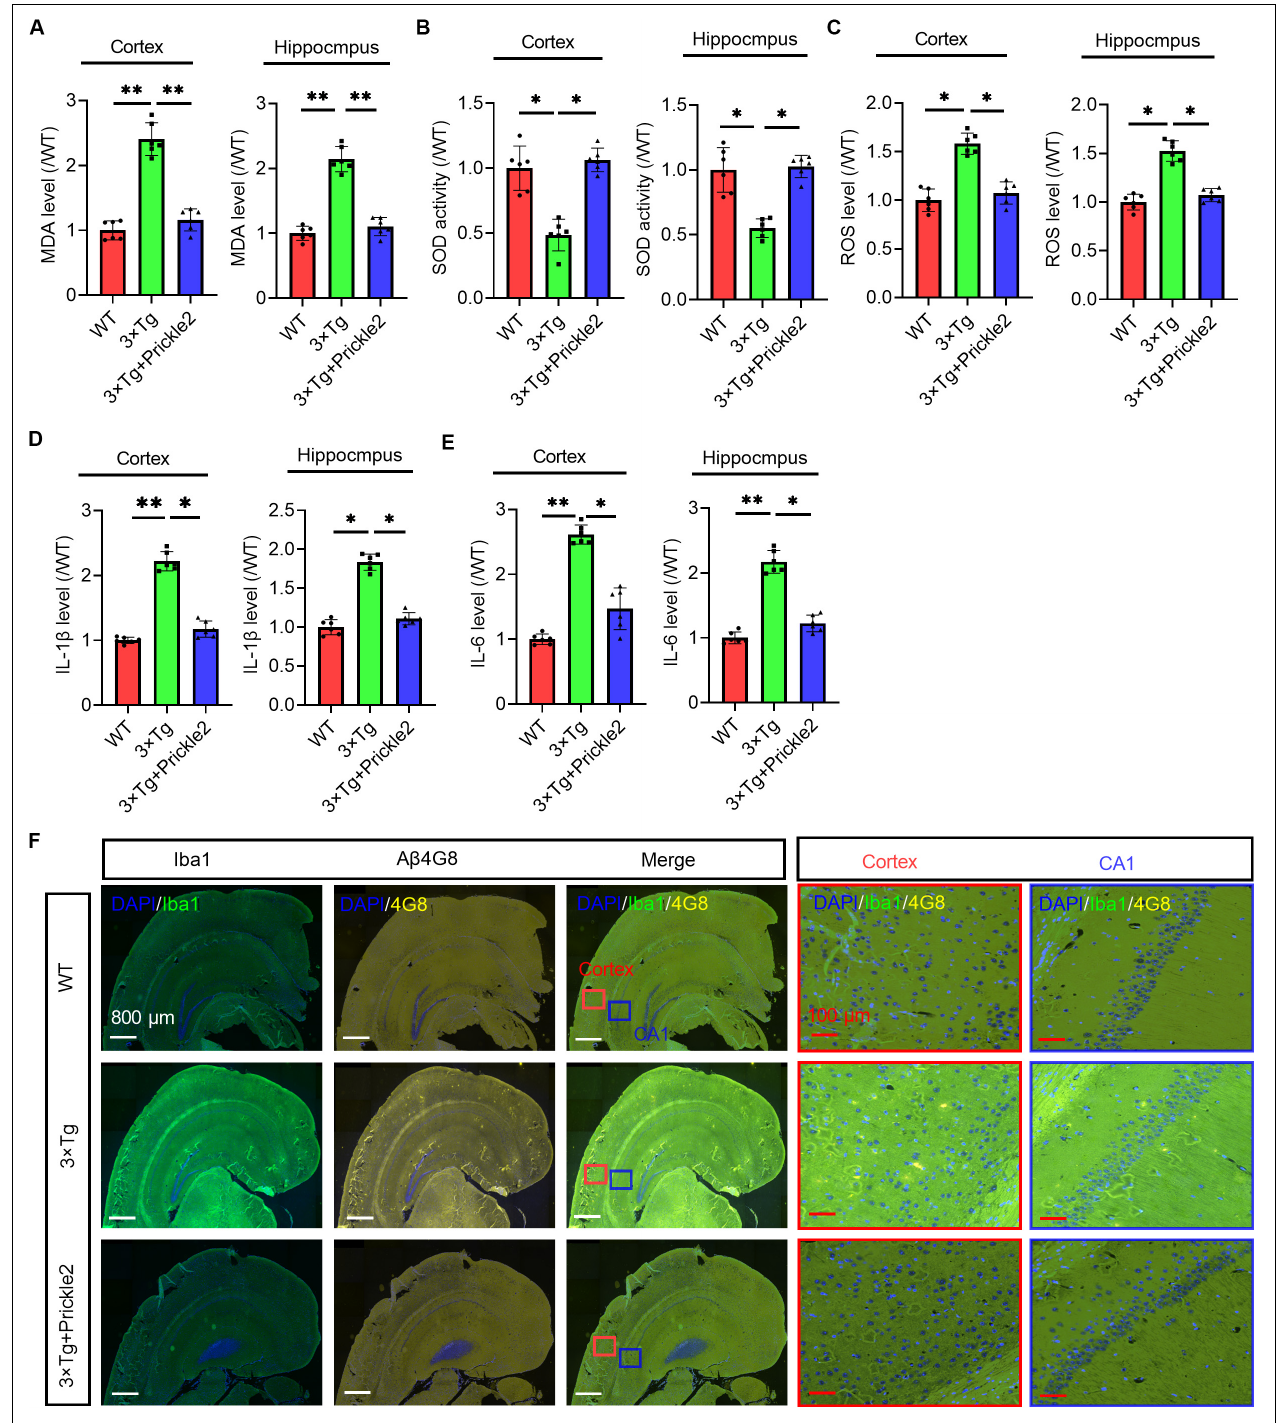
FIGURE 3 | Prickle2 overexpression ameliorates oxidative stress and neuroinflammation in 3 × Tg mice. (A) The level of MDA and (B) the activity of SOD was determined in the brain of WT, 3 × Tg and 3 × Tg/Prickle2 treatment mice ( n = 6 per group). (C) The ROS level was measured in the supernatants of the brain homogenates of WT, 3 × Tg and 3 × Tg/Prickle2 treatment mice ( n = 6 per group). (D) The levels of IL-1 β and (E) IL-6 were determined by ELISA in the brain of WT, 3 × Tg and 3 × Tg/Prickle2 treatment mice ( n = 6 per group). (F) Brain sections of the cortex and hippocampus were stained with anti-Iba1 and anti-A β 4G8 antibodies. (A–E) ANOVA followed by Bonferroni’s post hoc test. ∗ p < 0.05; ∗∗ p < 0.01.